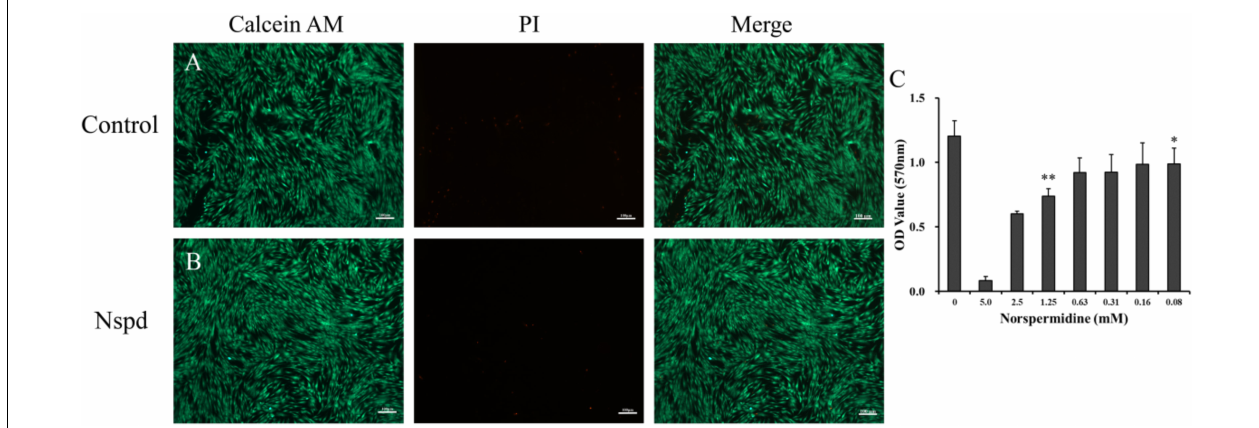
FIGURE 5 | Live/dead staining of DPSCs with and without Nspd and the cytotoxic of Nspd determined by MTT assay. (A) DPSCs cultured with α -MEM medium, the control. DPSCs were in spindle shapes and were well aligned in typical pattern. (B) DPSCs cultured with α -MEM medium containing 0.63 mM Nspd. Similar to those in the control, DPSCs were densely aligned. Calcein AM (green) was used to stain live stem cells and PI (red) was used to stain dead stem cells. Bar = 100 µ m. (C) To identify an optimal concentration of Nspd for DPSCs study, Nspd at various concentrations (0, 5.0, 2.5, 1.25, 0.63, 0.31, 0.16, and 0.08 mM, respectively) were used to culture DPSCs for 24 h. Live/dead cell viability for DPSCs. MTT assay was used to assess the viability and proliferation rate of DPSCs with presence of Nspd. Data were presented in mean ± standard deviation. *represented 0.08, 0.16, 0.32, and 0.64 mM of Nspd were significantly different from control group, (0 mM). **represented the result was significantly different from the 0.63 mM Nspd group.